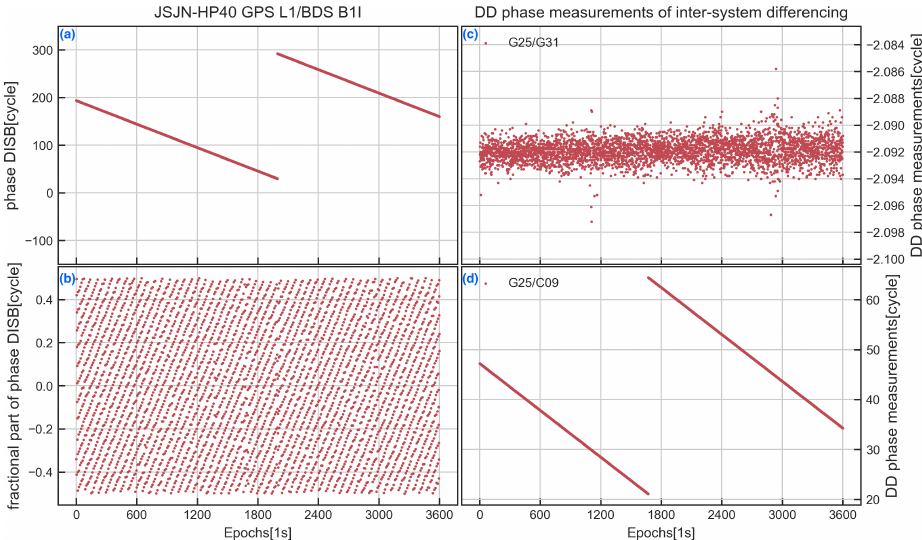
Figure 9. Time series of integral part ( a ) and the fractional part ( b ) of the phase DISB of GPS L1/BDS − 2 B1I, and the DD phase measurements of G25/G31 ( c ) and G25/C09 ( d